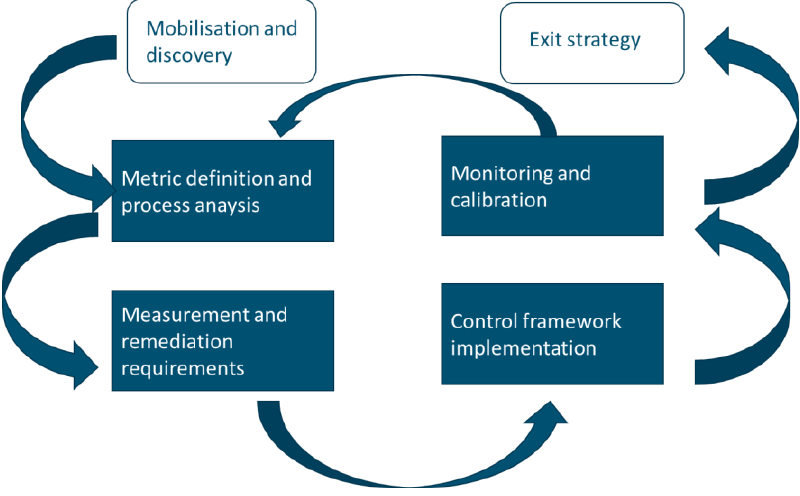
Figure 8. Waterfall like model development.